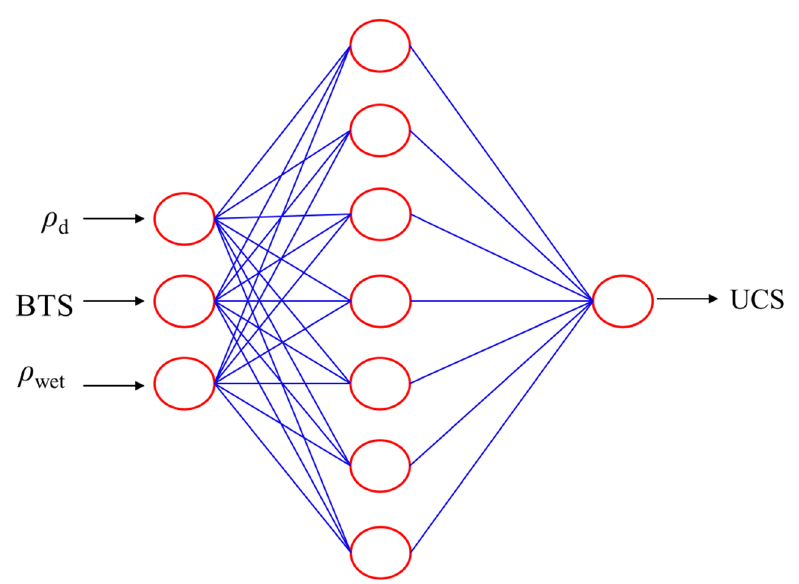
Figure 6. Structure of the artificial neural network.